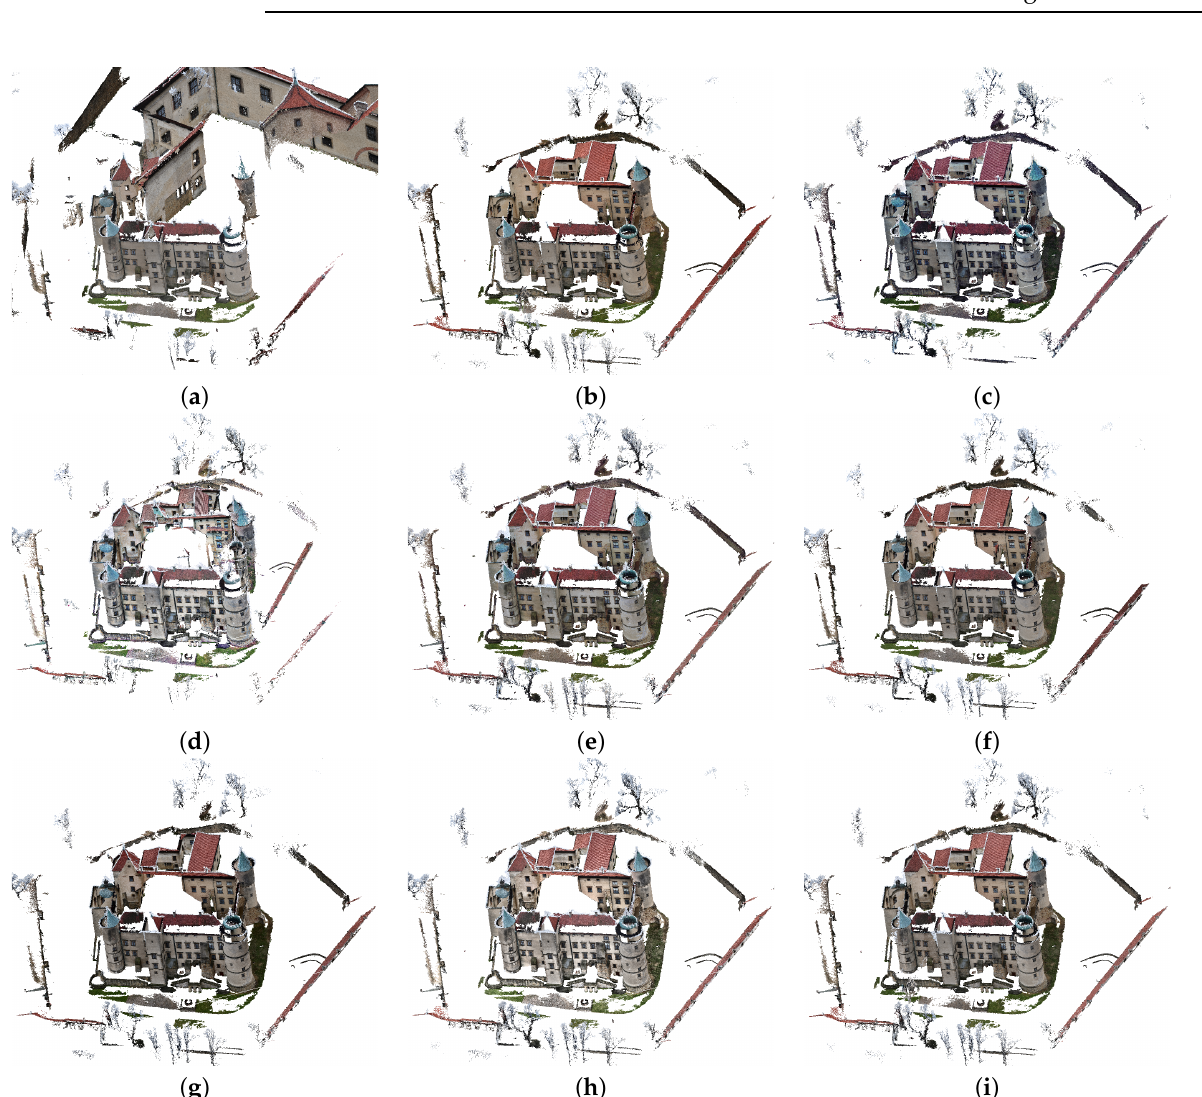
Figure 18. Dense point clouds of the castle. Reconstructions based on photographs: ( a ) original; preprocessed in the RGB space with the use of: ( b ) histogram stretching, ( c ) histogram equalizing, ( d ) adaptive equalizing, ( e ) exact histogram matching; preprocessed in the L*a*b* space with the use of: ( f ) histogram stretching, ( g ) histogram equalizing, ( h ) adaptive equalizing, ( i ) exact histogram